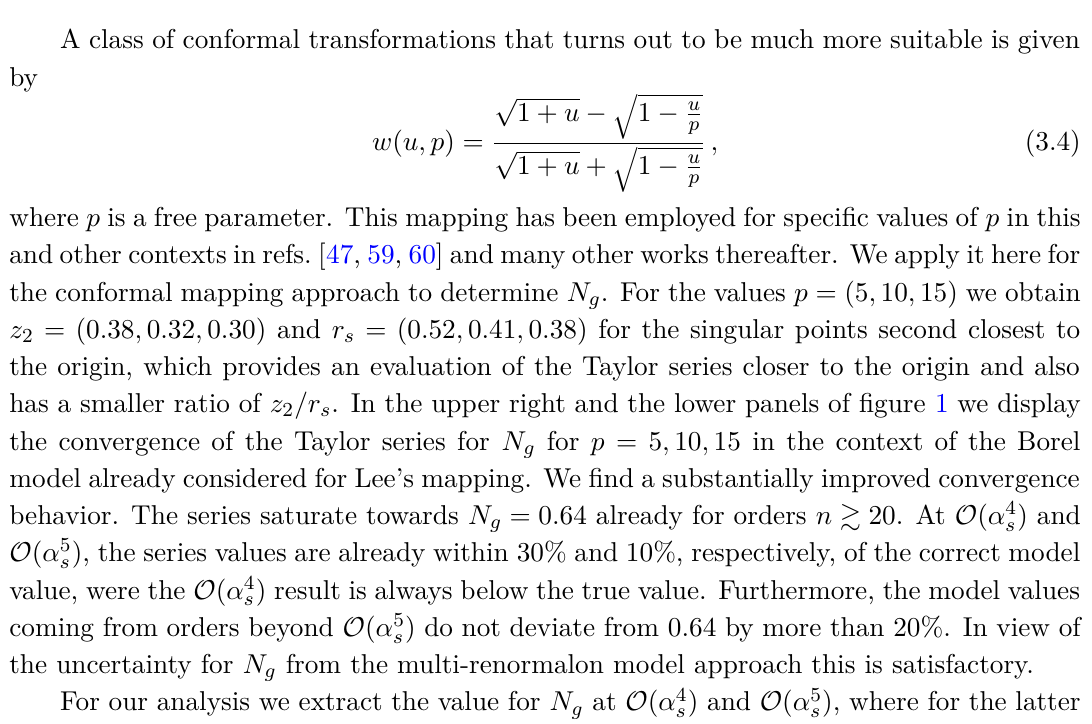
Table 1 . Results for the n f = 3 GC renormalon norm N g at O ( α 4 at order 5 come from varying ¯ c 5 , 1 within the uncertainty estimate given in eq.